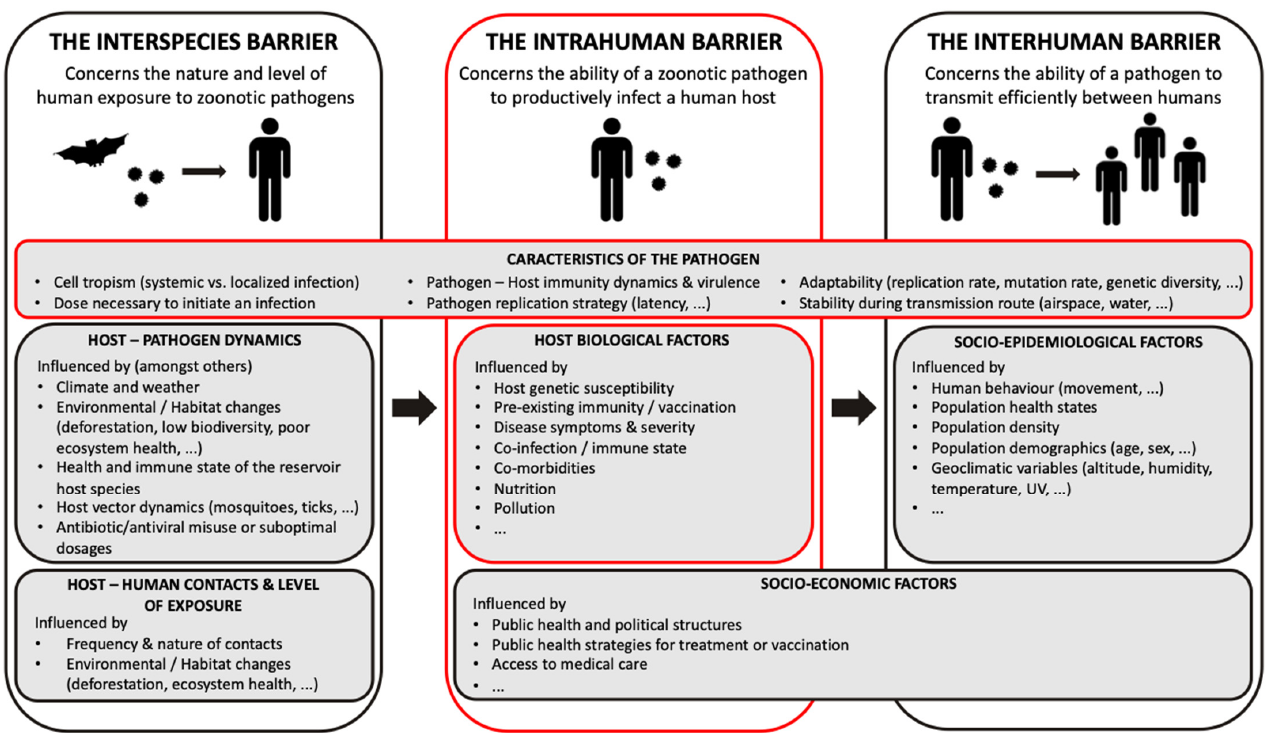
Figure 1. The three species barriers to zoonotic transmission and the factors that influence the ability of emerging or re-emerging zoonotic pathogens to cause epidemics/pandemics in humans. For a pathogen to be able to establish sustainable transmission chains in humans, all three barriers must be effectively surpassed. Boxes shown in red concern the pathogen and host factors and their interactions that are crucial in determining the relative success of a species jump for an animal virus to humans and which are developed further in this review. Further details are given in the text. Adapted with permission from [19]. Copyright 2022, Revue CONFLUENCE Sciences & Humanités.